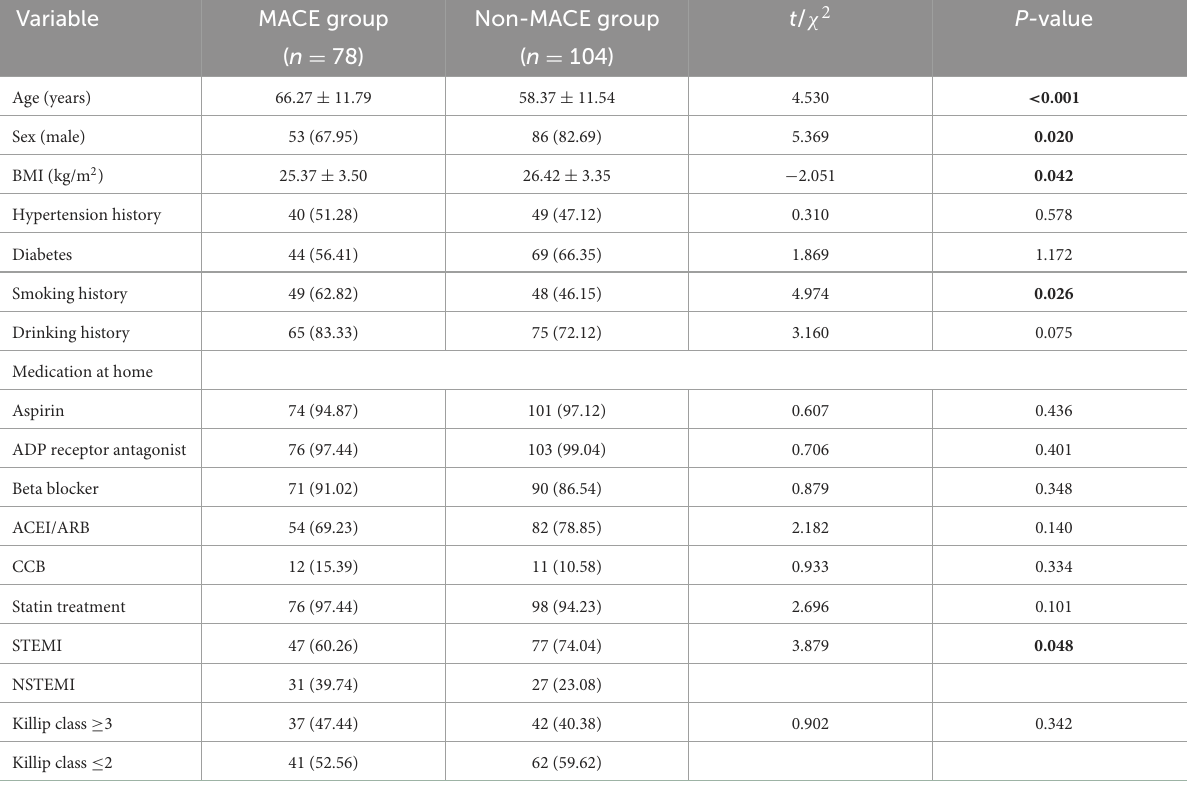
TABLE 2 Comparison of basic clinical data between the MACE and non-MACE groups.